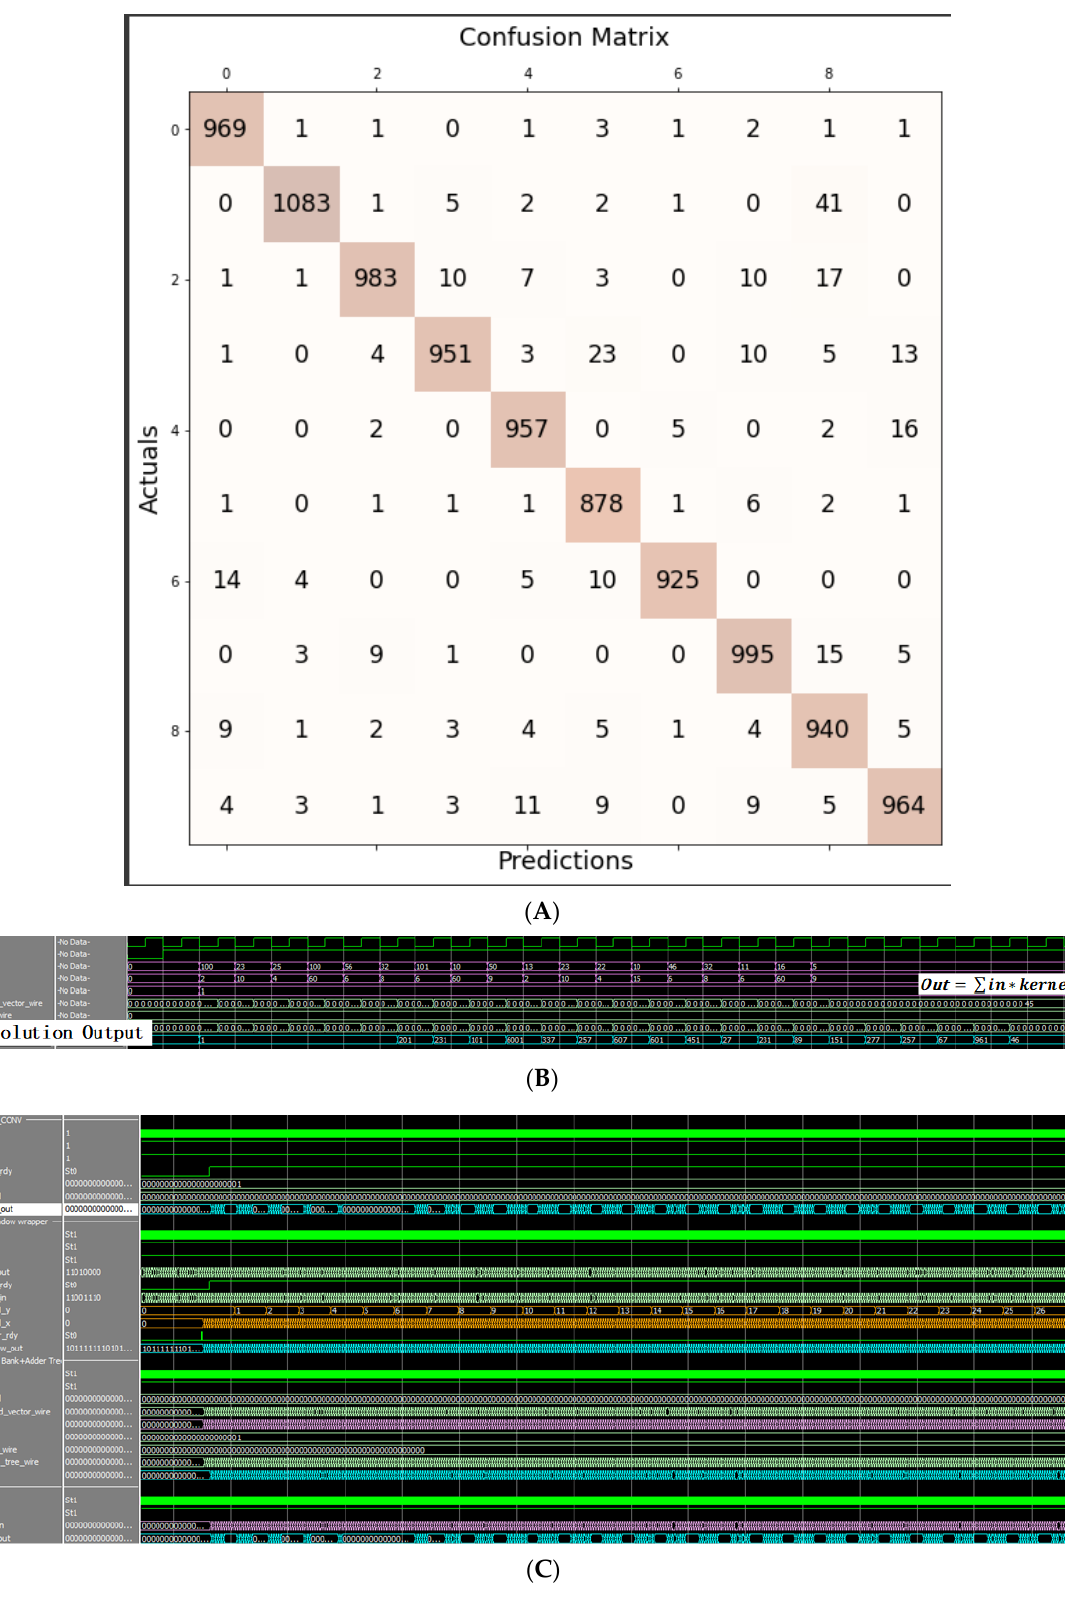
Figure 13. ( A ) Tensor flow result of Proposed CNN. ( B ) Result of Convolutional Layer. ( C ) Result of the proposed CNN engine with controller.